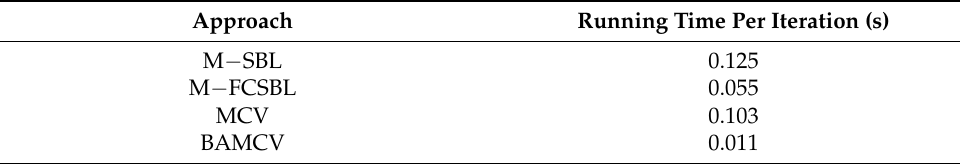
Table 5. Comparison of running time per iteration using simulated data.